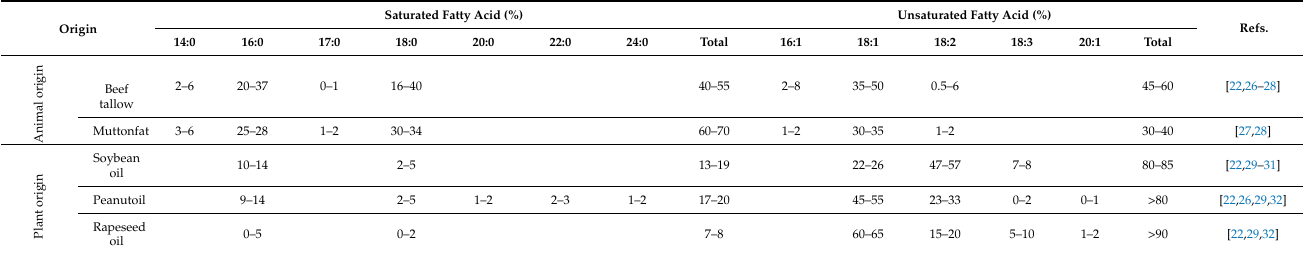
Table 1. Typical fatty acid composition of lipids in food waste.